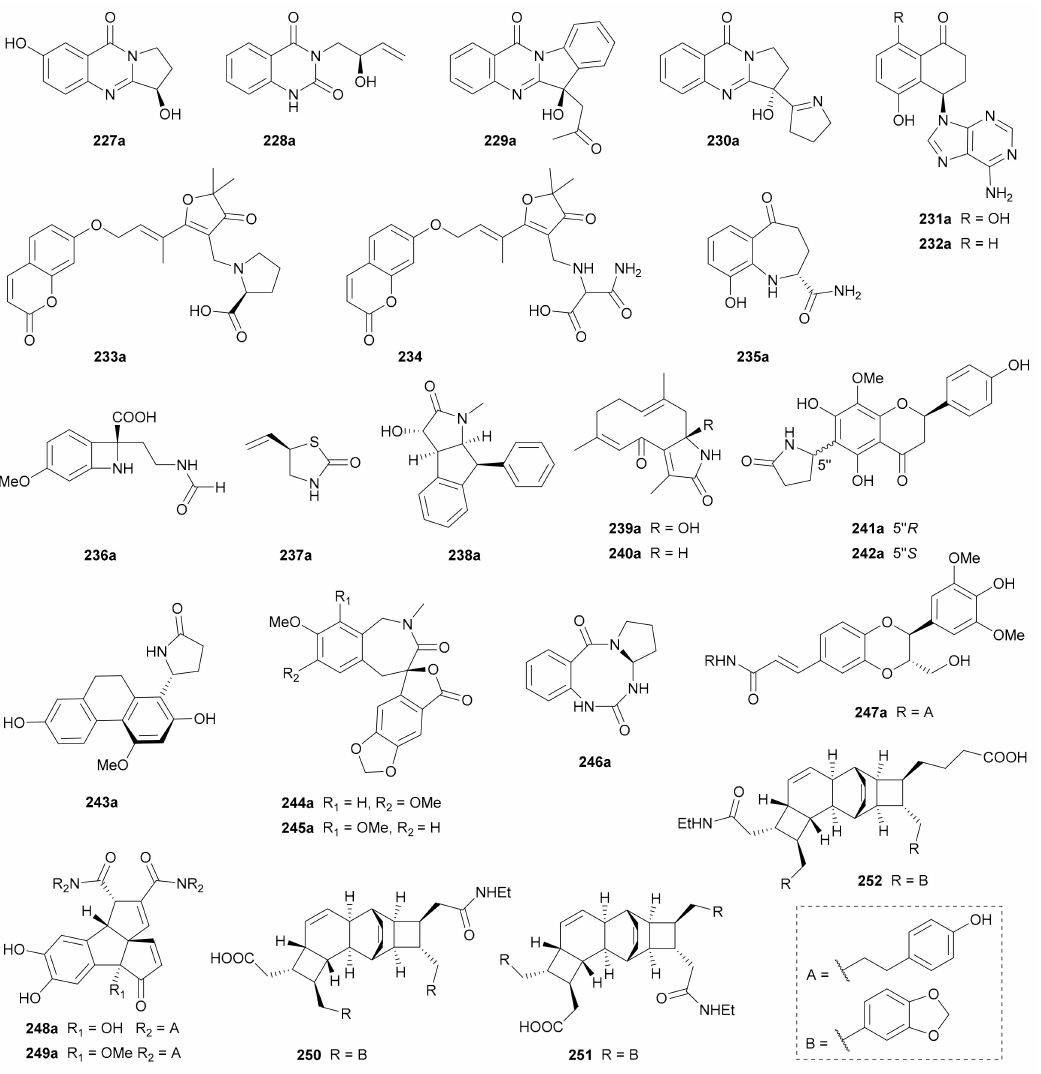
Figure 14. Structures of other